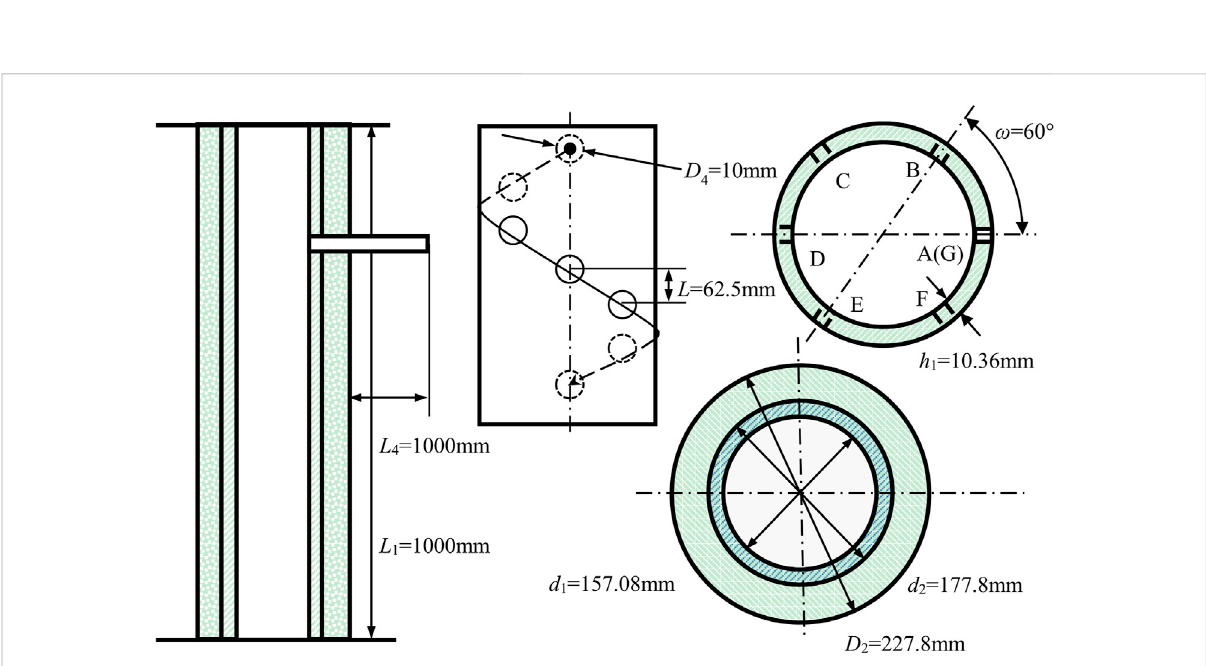
FIGURE 3 Schematic diagram of perforation